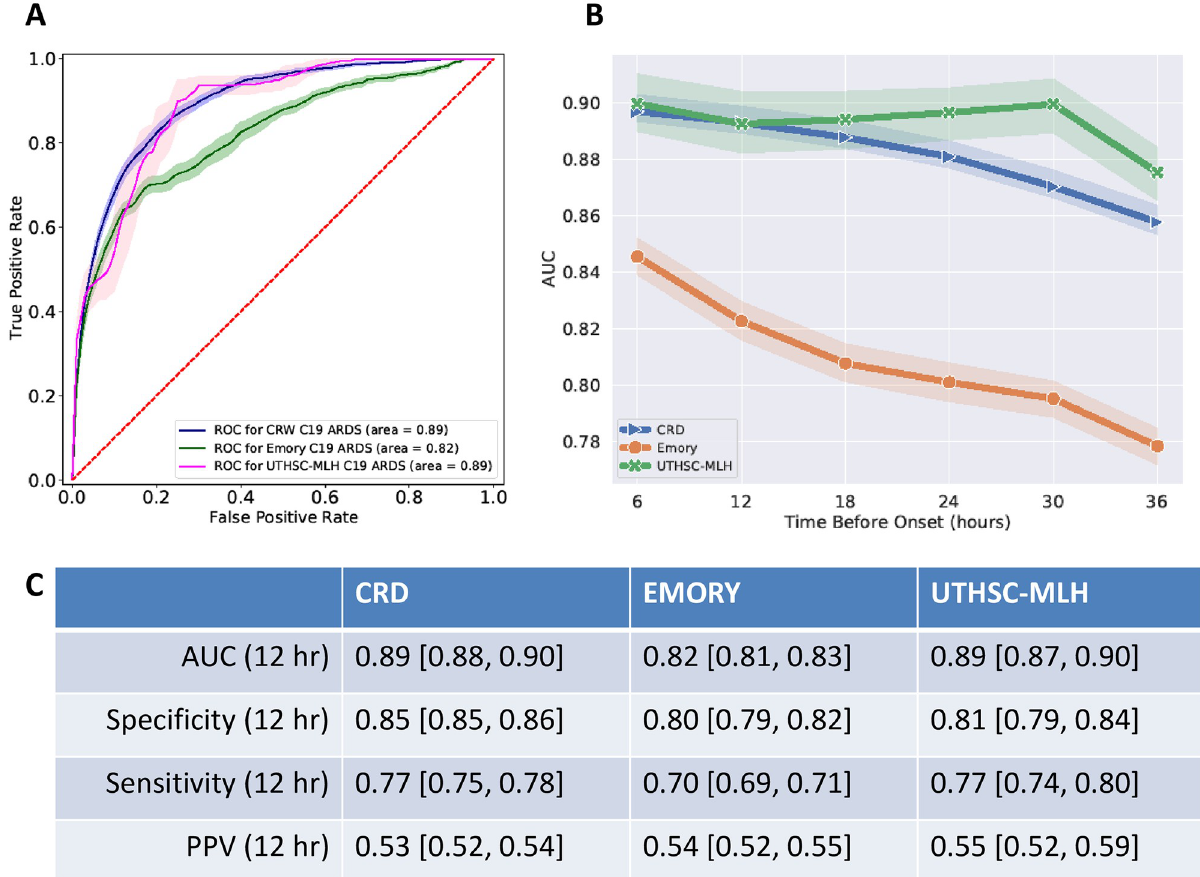
Fig 2. Model performance and feature importance. A. The AUROC performance of the eARDS model over hold-out and validation datasets, 95% CI, are illustrated as shaded bands for each model. B. Temporal performance of the model over different prediction horizons ranging from t onset to 36 hours before, MLH is shown to have the highest performance over the time periods, while Emory data has the lowest AUC consistently. C. Depicts the performance measures of the algorithm across the three datasets at 12-hours before ARDS onset.